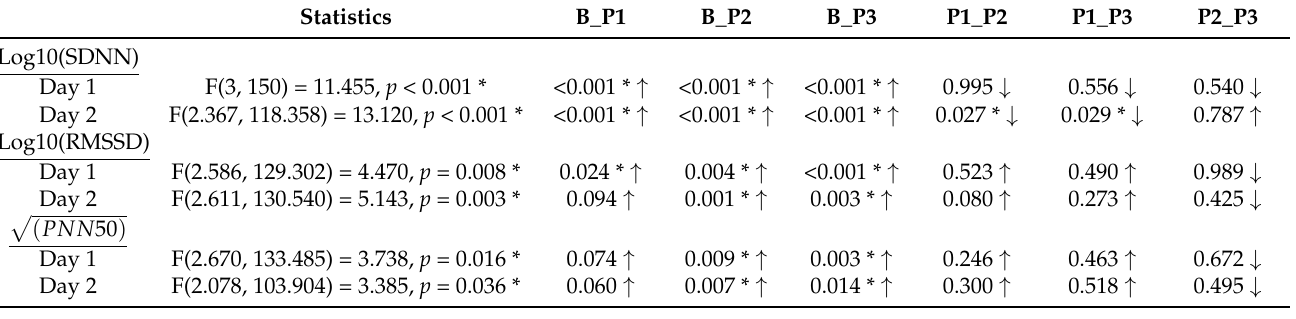
Table 5. The effect of deep breathing on HRV in patients with RA and SLE reported with a one-way repeated measures ANOVA and p -values of the post hoc test. A significant increase was observed from baseline to post measurements for SDNN, RMSSD, and PNN50 on both days, and the HRV-parameters remained elevated throughout the post measurements. HRV: Heart rate variability. RA: Rheumatoid Arthritis. SLE: Systemic Lupus Erythematosus. ANOVA: Analysis of Variance. * Shows statistical significance. ↑ Shows an increase with respect to the baseline. ↓ Shows a decrease with respect to the baseline. Statistics: F(df (Time), df (Error (Time))) = F-value, p -value. SDNN: The standard deviation of the R-R intervals. RMSSD: The root mean square of successive R-R intervals. PNN50: The proportion of NN50 (pairs of successive R-R intervals that differ more than 50 milliseconds) divided by the total number of R-R intervals. Post1, post2, and post3 were performed at 0–5, 12.5–17.5, and 25–30 min after the deep breathing intervention, respectively. “B_PX” refers to the comparison between baseline and post1, post2, or post3. “PX_PX” refers to the comparison between post1, post2, or post3.